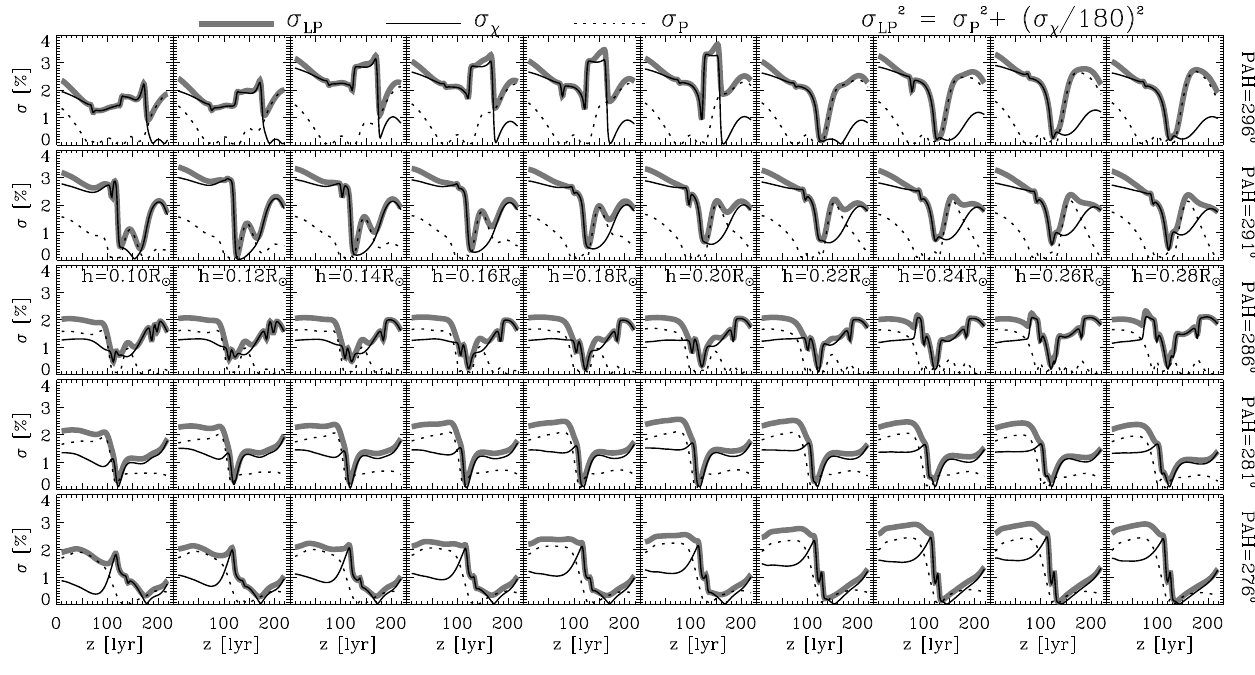
Fig. 1. Error profiles for the five coronal regions with PAH at 296, 291, 286, 281, and 276 degrees, respectively. The location ( z or layer best ) of the minimum error in a σ LP profile is thought to be the dominant IR coronal “emission source” along the LOS. For convenience, only the 1st–10th fibers at the 3rd row of the fiber head array (16 × 8) are shown for each coronal region. Most profiles (thick gray lines; σ LP ) show a clear minimum value between layer 120 (above a sunspot) and layer 155 (the plane of the sky through the sun center). σ p and σ χ are the difference between the theoretical results and SOLARC observations for linear polarization degree and azimuth angle, respectively. Note, 1 lyr = 4 . 5 Mm.